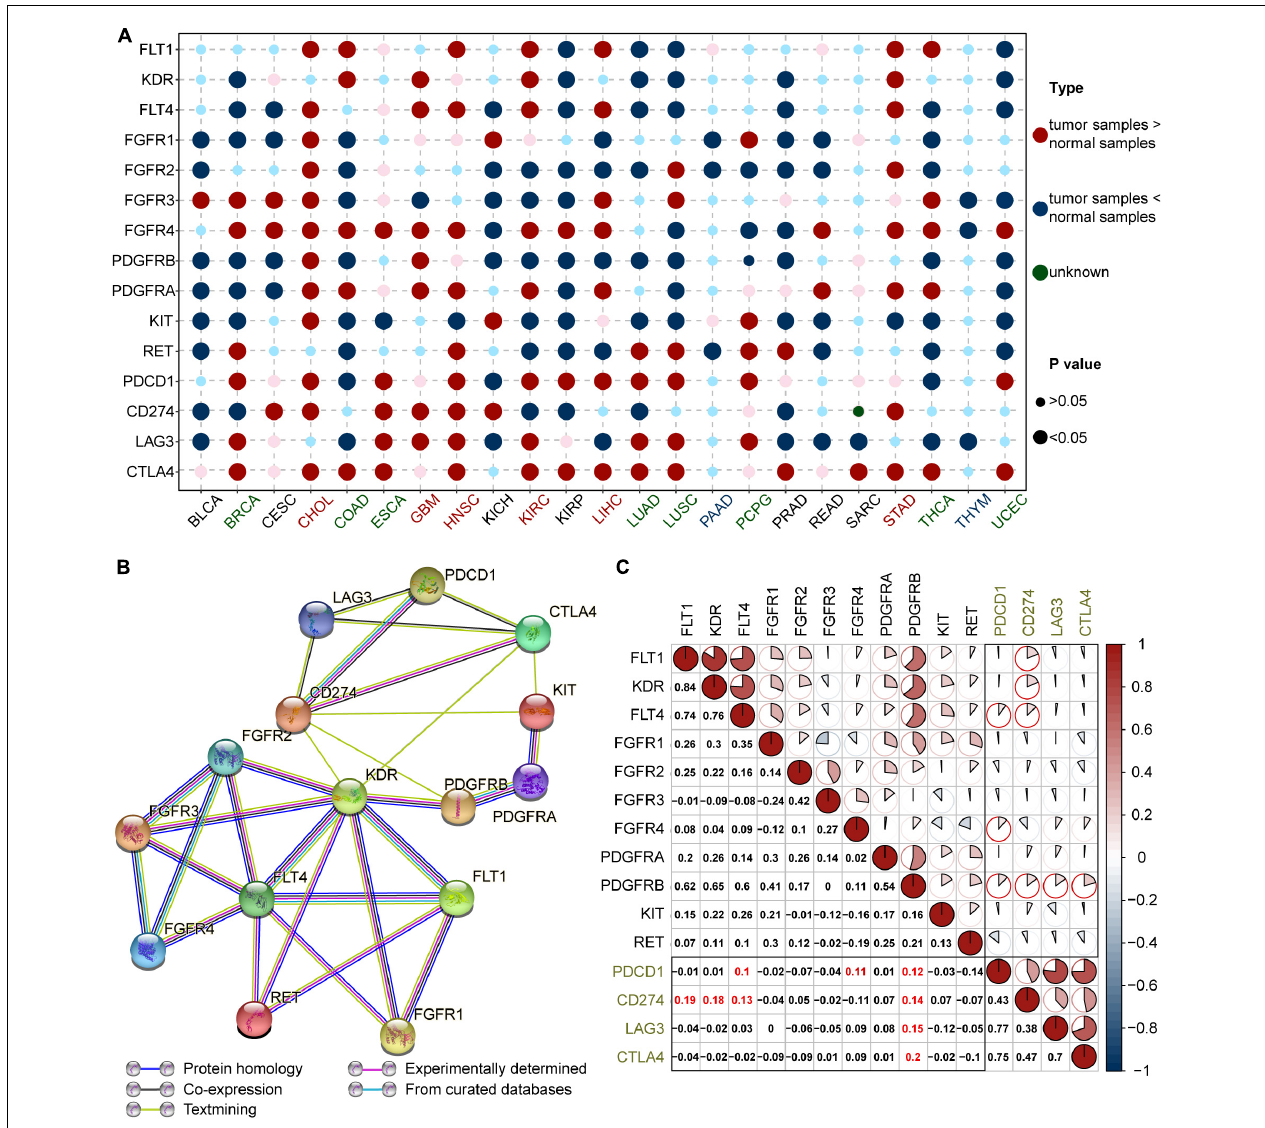
FIGURE 2 | Expression and correlation of ICB and lenvatinib targets. (A) Comparison of ICB and lenvatinib target genes expression in tumor tissue and corresponding normal tissue. The cancer types in red text represent high expression of both lenvatinib ( ≥ 4 large red circles) and ICB ( ≥ 2 large red circles) target genes; green text represents moderate expression defined as higher expression of either lenvatinib ( ≥ 4 large red circles) or ICB ( ≥ 2 large red circles) target genes; blue text represents low expression of both lenvatinib and ICB target genes (no large red circles for either). (B) PPI network construction of lenvatinib and ICB target genes. (C) Correlation coefficient graph of ICB and lenvatinib target genes in pan-cancer. Numbers and the pie chart size correspond to the Pearson correlation coefficient ( r value). The black boxes are the intersecting sections, and the red highlighted text and circles are r ≥ 0.1. BRCA, breast invasive carcinoma; CESC, cervical squamous cell carcinoma and endocervical adenocarcinoma; ESCA, esophageal carcinoma; KICH, kidney chromophobe; KIRC, kidney renal clear cell carcinoma; KIRP, kidney renal papillary cell carcinoma; LUAD, lung adenocarcinoma; LUSC, lung squamous cell carcinoma; PAAD, pancreatic adenocarcinoma; PCPG, pheochromocytoma and paraganglioma; PAAD, prostate adenocarcinoma; SARC, sarcoma; STAD, stomach adenocarcinoma; THYM, thymoma; ICB, immune-checkpoint blockade; FLT1 (VEGFR1), vascular endothelial growth factor receptor 1; KDR (VEGFR2), vascular endothelial growth factor receptor 2; FLT4 (VEGFR3), vascular endothelial growth factor receptor 3; FGFR, fibroblast growth factor receptor; PDGFR, platelet derived growth factor receptor; KIT, stem cell factor receptor; RET, the rearranged during transfection; PDCD1 (PD-1), programmed cell death 1; CD274 (PD-L1), programmed cell death ligand 1; LAG3, lymphocyte-activation protein 3; CTLA4, cytotoxic T-lymphocyte-associated antigen